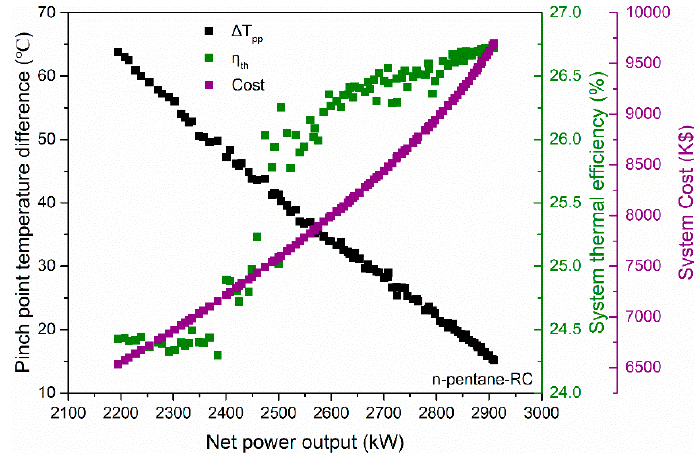
Figure 8. The scattered distribution of the pinch point temperature difference, thermal efficiency, and system cost for the Pareto frontier.